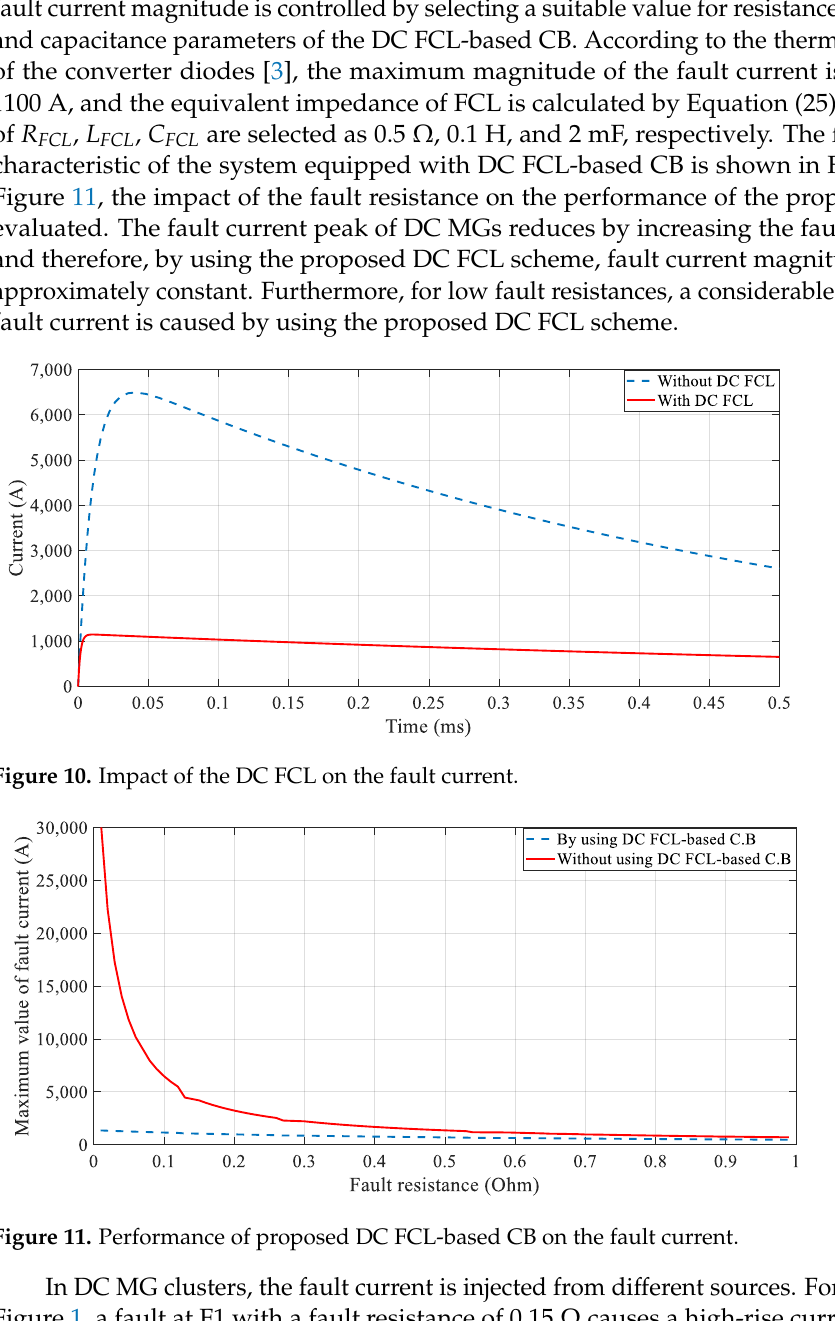
Figure 12. Fault current contributions without FCL, from grid and DC MGs.